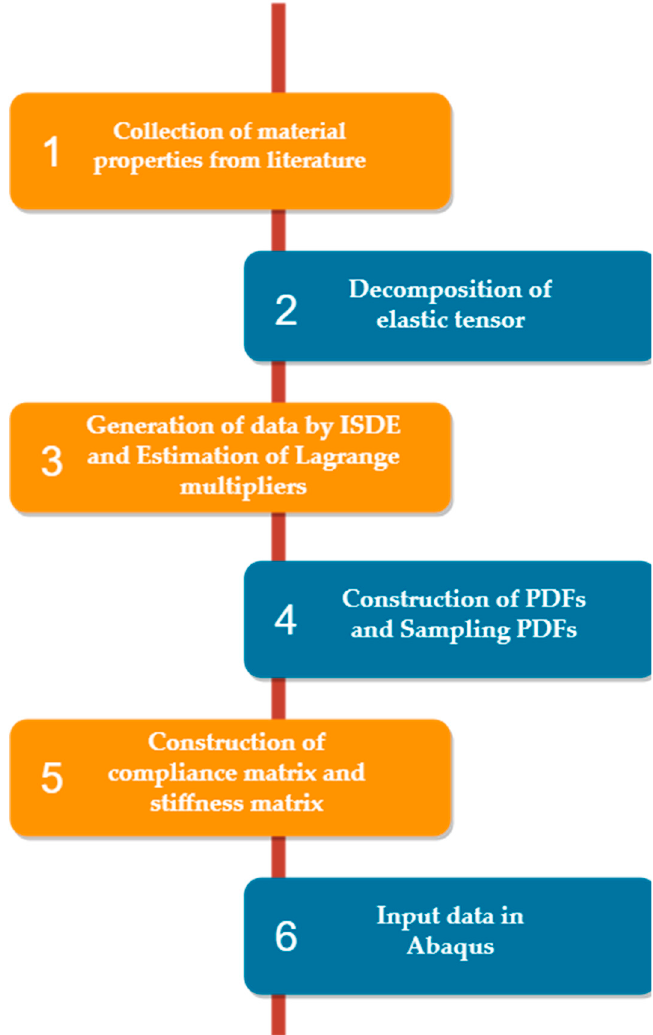
Figure 10. Flow chart of the application of the stochastic process .